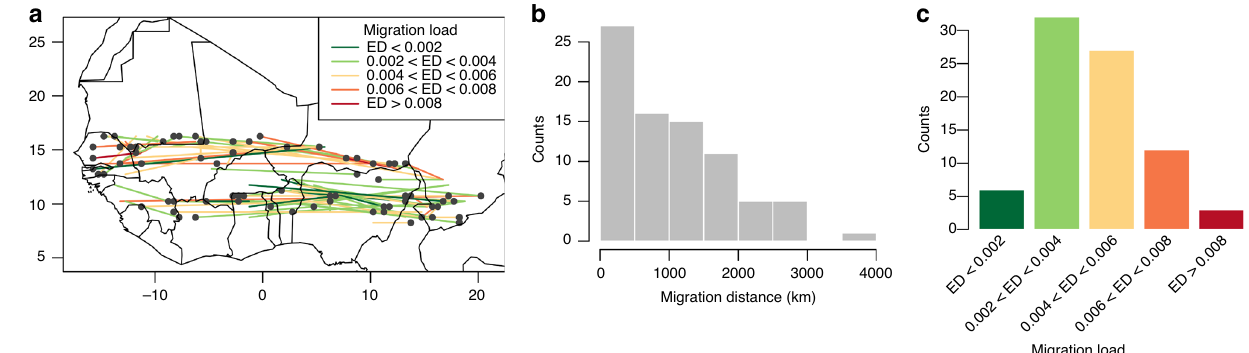
Fig. 4 Assisted migration of pearl millet varieties for adaptation to future climate at the 2050 horizon. All the fi gures are based on the RCP8.5 scenario. a Migration trajectories are indicated by colored lines linking one of the 80 most vulnerable locations (black dots) to the location selected for optimal migration of varieties to minimize future genomic vulnerability. b Migration distance distribution. c Migration load distribution. The migration load refers to the genomic vulnerability of landraces after migration under future climate projections. High migration load values identify migrations that rely on potentially ill-adapted migrated varieties as no other varieties that are better adapted to future climate conditions exist in the